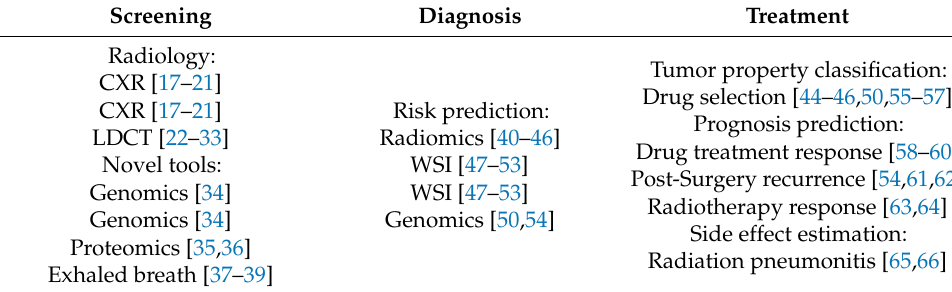
Figure 1. Venn diagram of artificial intelligence (AI), machine learning (ML), neural network, deep learning, and further algorithms in each category. AI is a general term for a program that predicts an answer to a certain problem, where one of the conventional methods is logistic regression. ML learns the algorithm through input data without explicit programming. ML includes algorithms such as decision trees (DTs), support vector machines (SVMs), and Bayesian networks (BNs). By using each ML algorithm as a neuron with multiple inputs and a single output, a neural network is a structure that mimics the human brain. Deep learning is formed with multiple layers of neural networks, and convolutional neural network (CNN) is one of the elements of the famous architecture. Table 1. Summary of AI application fields.